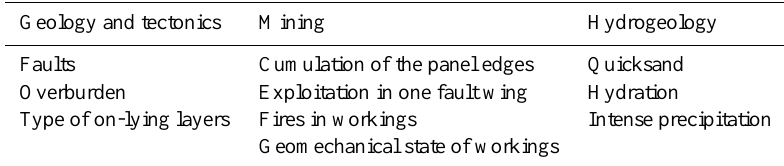
Table 2. Qualitative risk factors.